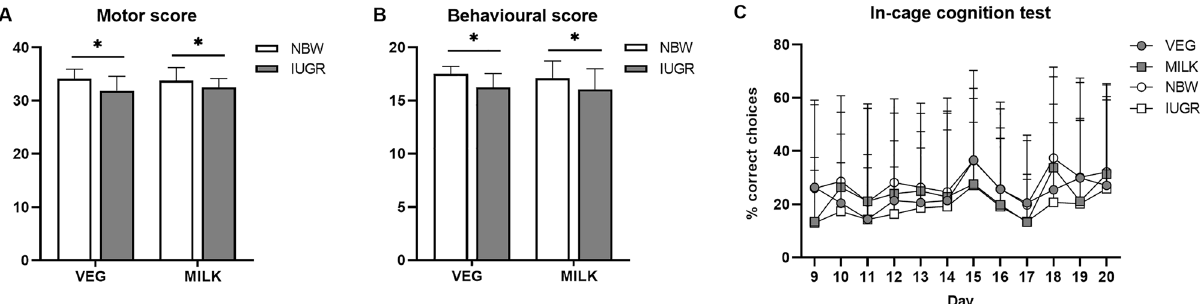
Figure 1. Behavioural, cognitive and motor function tests. ( A ) Motor score day 7, ( B ) behavioural score day 7 and ( C ) in-cage cognition test—percentage correct choices on day 9–20. In ( A ) and ( B ), n = 9. In ( C ), data are pooled and presented as main effects of diet and birth weight (n = 18). Data are shown as mean ± SD. All data were analysed using a linear mixed model. Statistically significant differences between groups are shown as *p < 0.05. All figures were created with GraphPad Prism (version 9.3.0, GraphPad Software, San Diego, California, USA). VEG vegetable oil, MILK bovine milk fat, NBW normal birth weight, IUGR intrauterine growth restricted.